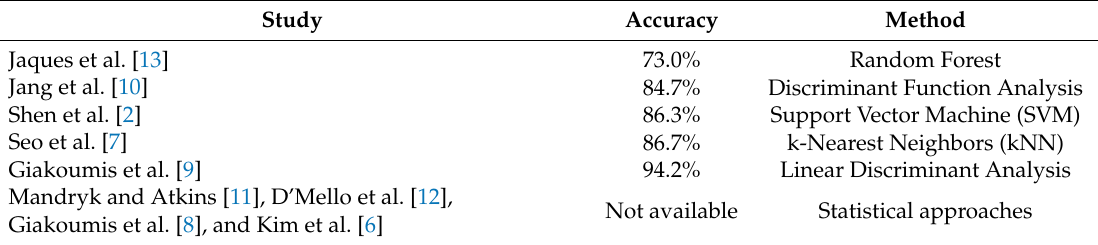
Table 2. Methods and accuracies of previous boredom classification